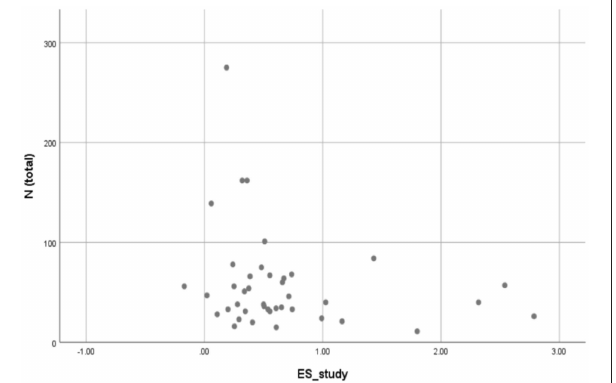
FIGURE 4 | Funnel